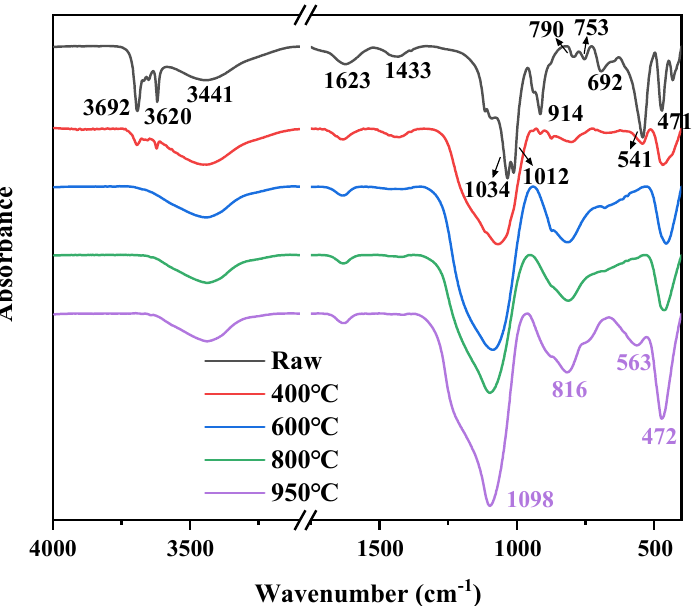
Figure 10. FT-IR patterns of calcined coal gangues at different temperatures.